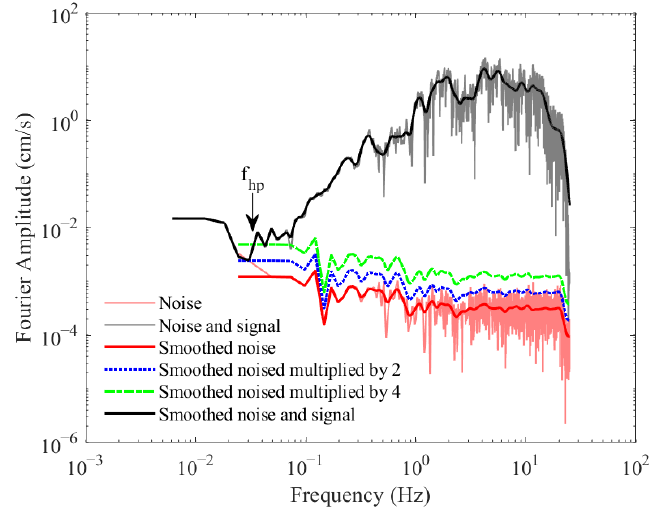
Figure 11. Illustrative plot for selecting filter corner frequencies.